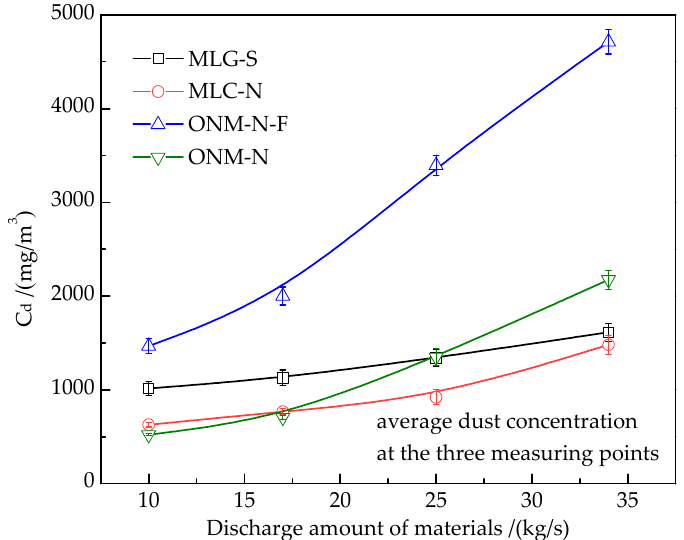
Figure 7. Effects of the discharging amount of materials on the average dust concentration of chute at the three measuring